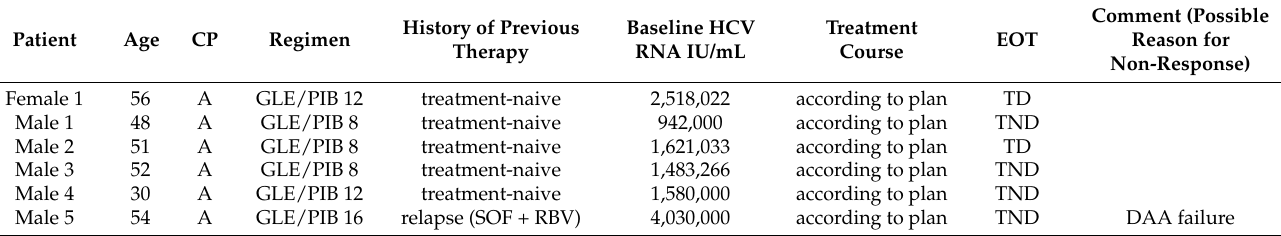
Table 4. Characteristics of 6 virologic failures to GLE/PIB regimen.